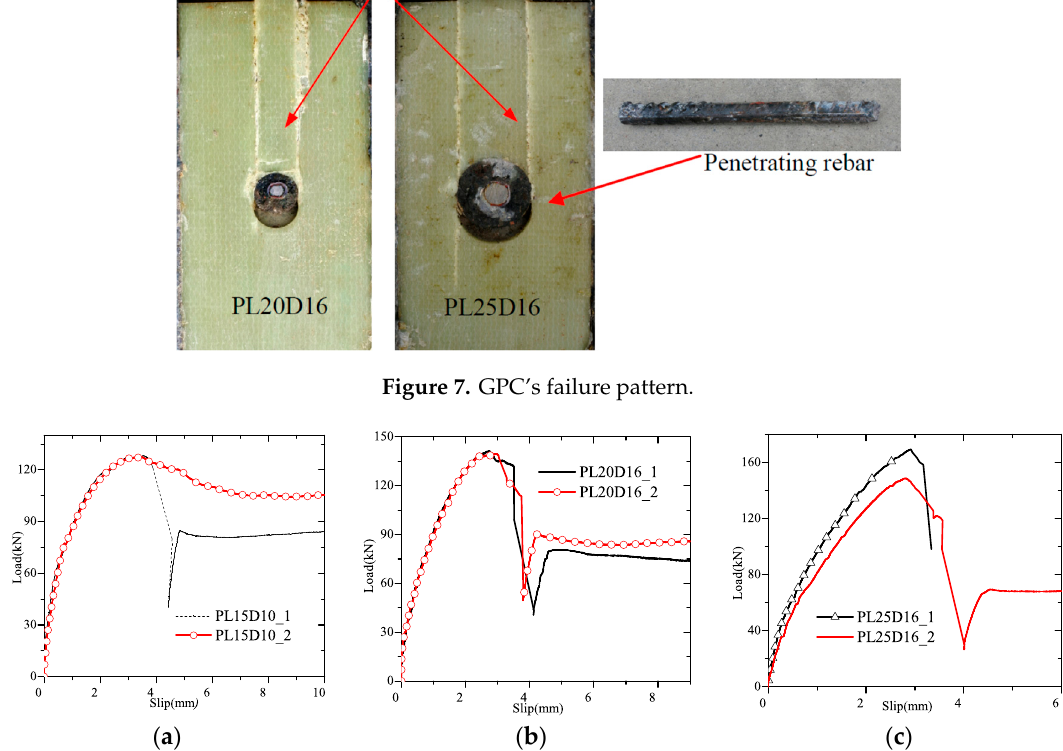
Figure 8. Load-slip curves of GPC. ( a ): PL15D10; ( b ): PL20D16; ( c ) PL25D16.